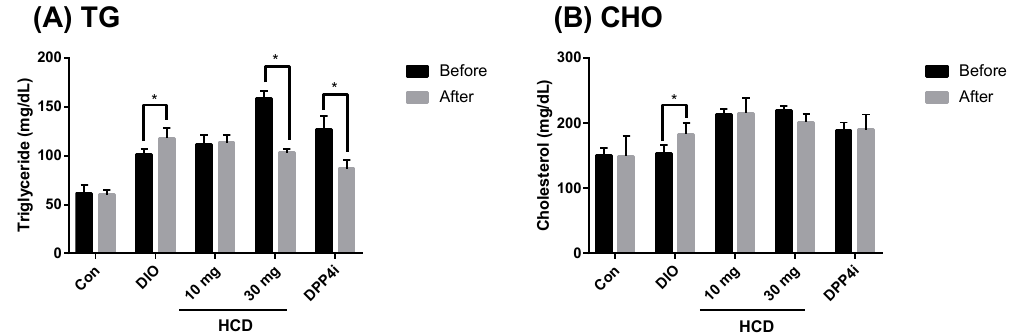
Figure 7. Alteration of serum lipid levels after selected natural compounds’ administration. HCD and sitagliptin (DPP4i) were fed to DIO mice for 5 weeks, respectively, and serum monitored ( A ) triglyceride and ( B ) cholesterol after treatment. All results were mean ± SD from 6 individuals. * p < 0.05 meant significantly different as compared with that before treatment .